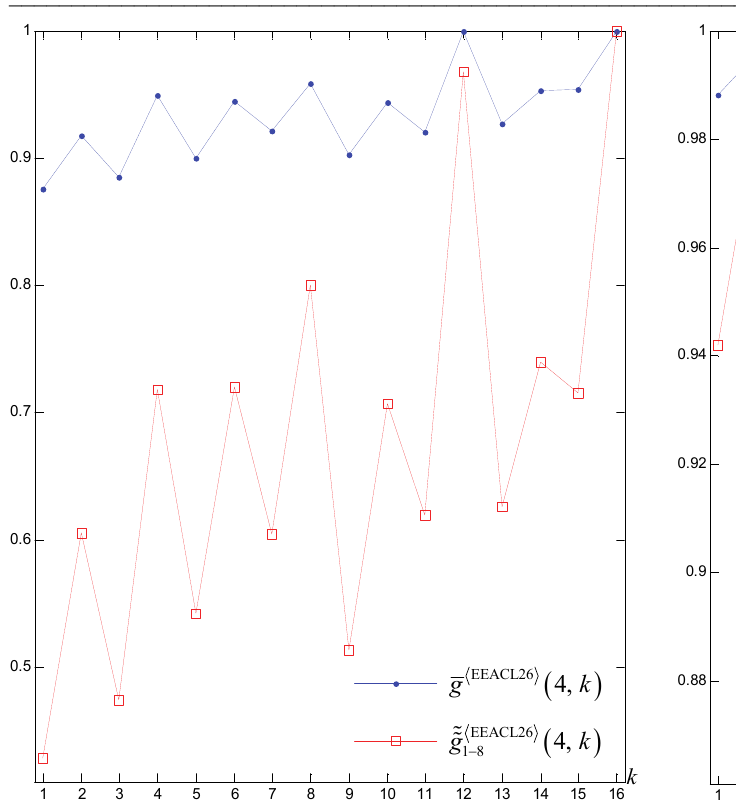
Fig. 14. The normalized averaged RERD (16) and the normalized averaged 4 N  on EEACL26. Maxima are very strange. final-epoch RERD (17) by ConvL